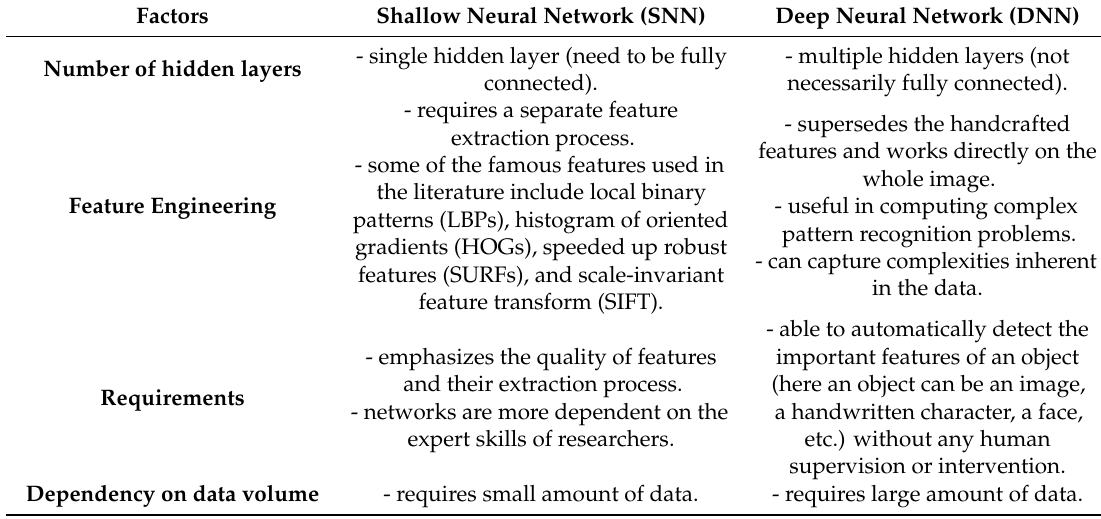
Table 1. Shallow neural network vs deep neural